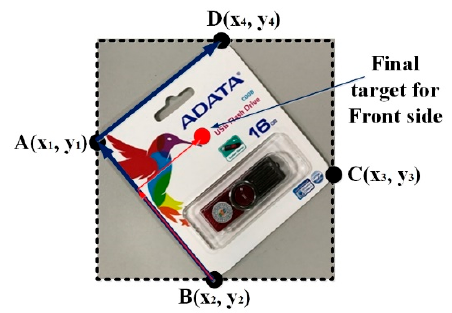
Figure 12. Method of calculating the final target for the front side case.